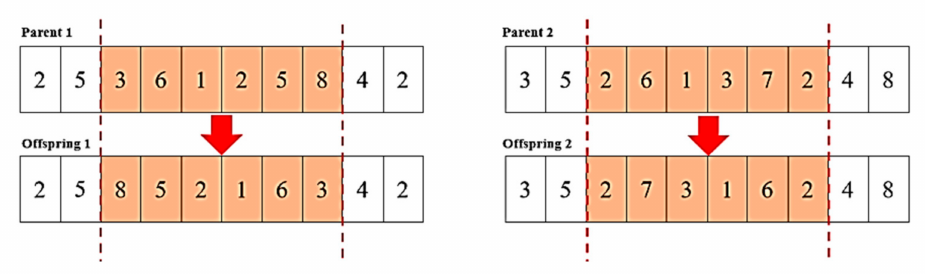
Figure 7. Inversion mutation operator.